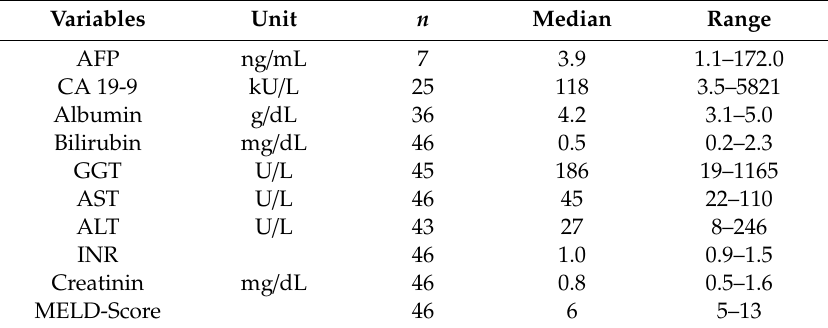
Table 3. Pretherapeutic laboratory values of patients with diagnosed ICC.